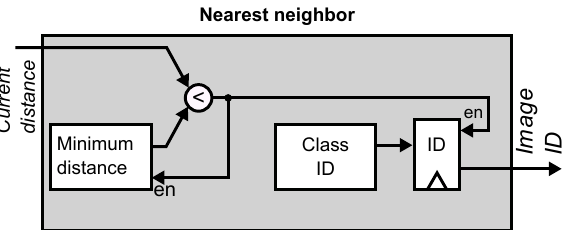
Figure 13. Classification module. The module implements a nearest neighbor criterion by selecting the face label that corresponds to the minimum distance computed between the input image and the stored database of know